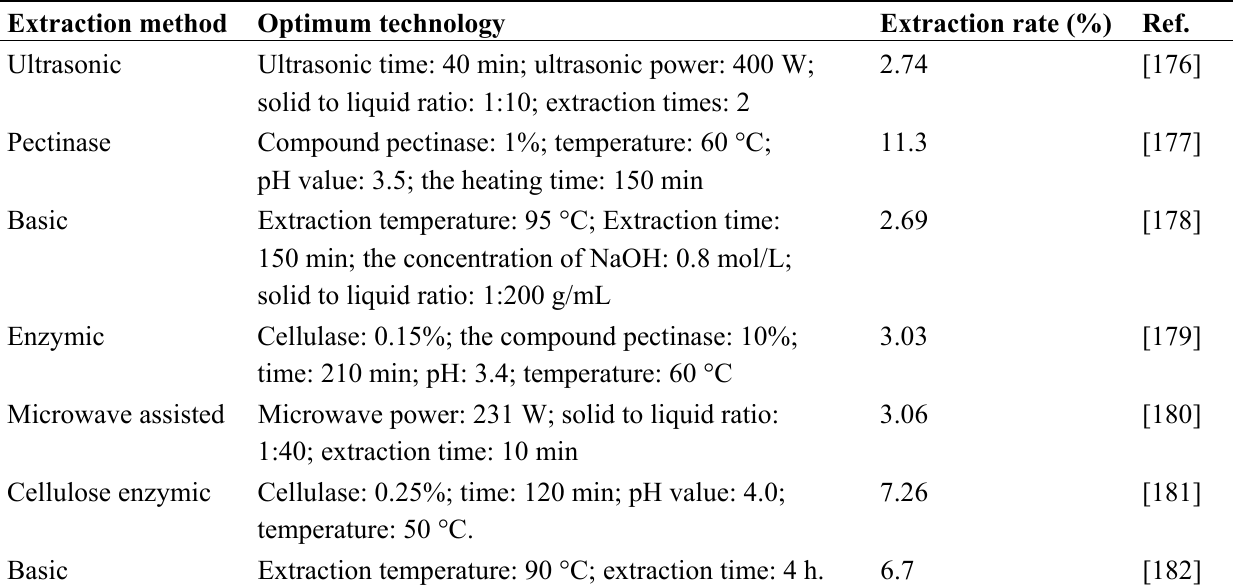
Table 5. The extraction methods of polysaccharide in